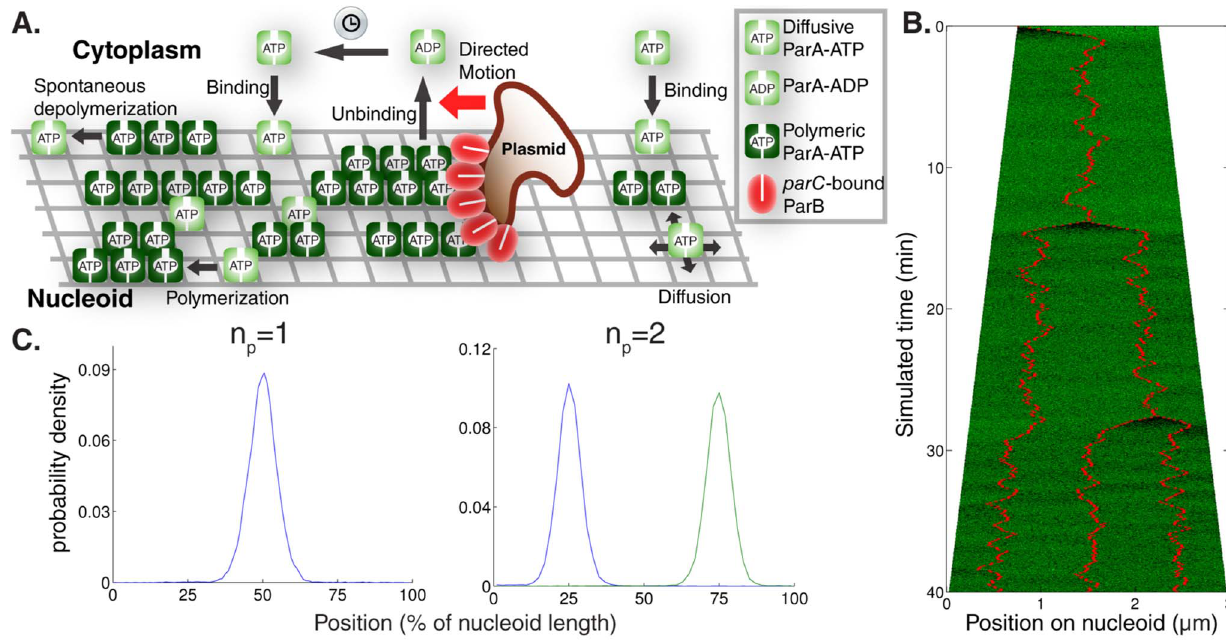
Fig. 4. The directed motion model can move and maintain plasmids at equally spaced positions. ( A ) Schematic illustration of par2 directed motion model. The clock indicates the slow conversion of cytoplasmic ParA-ADP into cytoplasmic ParA-ATP that is competent to bind to the nucleoid. ( B ) Typical simulation kymograph of directed motion model with short polymers for a simulated growing cell where a plasmid (red) is initially directed from a nucleoid edge to mid-cell by ParA (green) filament competition. After plasmid duplication, the system dynamically self- organizes to attain equal spacing. ( C ) Time-averaged plasmid position distributions for directed motion model with short polymers for n p =1,2 plasmids on a simulated nucleoid growing from 1.5 m m to 3 m m in 40 min without plasmid duplication. Plasmid distributions were obtained by sampling positions every 5 s in 36 independent simulations.